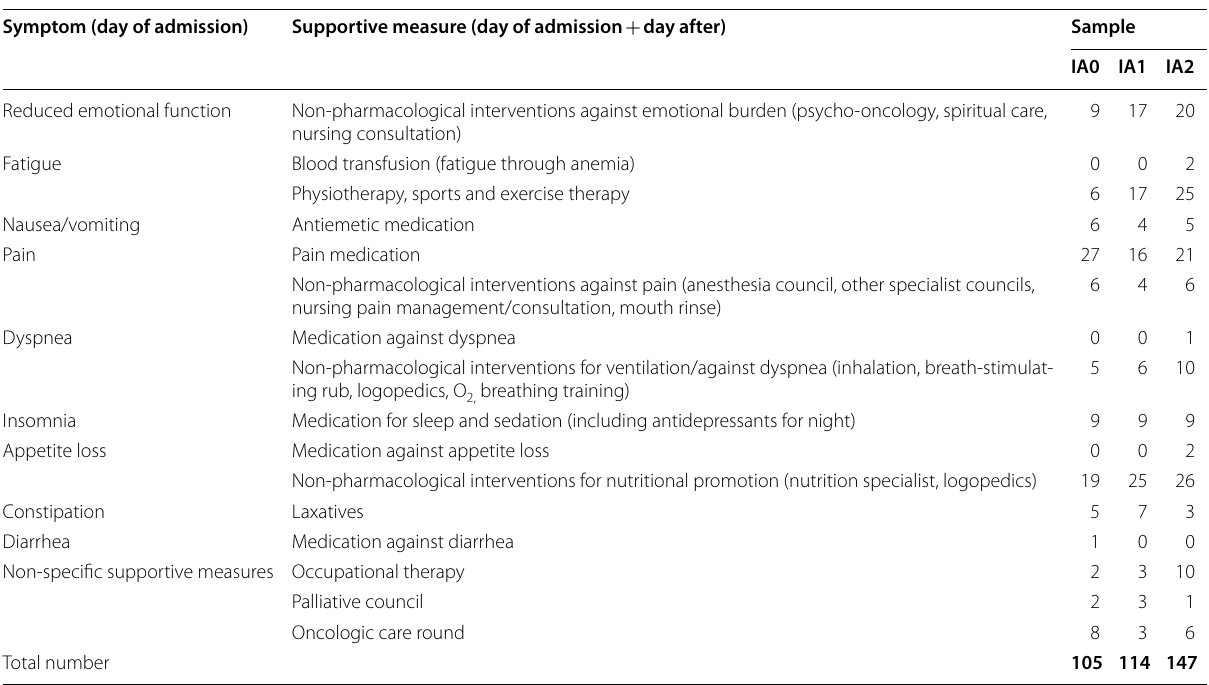
IA0 without initial assessment, IA1 with initial assessment, without integration of results into electronic patient records, IA2 with initial assessment, with integration of results into electronic patient records